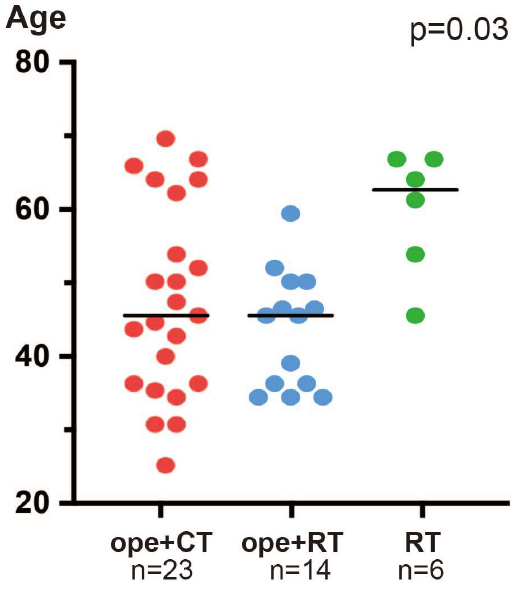
apy, NAC: neoadjuvant chemotherapy, NED: no evidence of disease, OS: overall survival, RFS: re- Figure 1). After October 2018, when the treatment strategy changed, only two of the currence-free survival, and BSC: best supportive care. six patients in the RT group were older than 70 years.